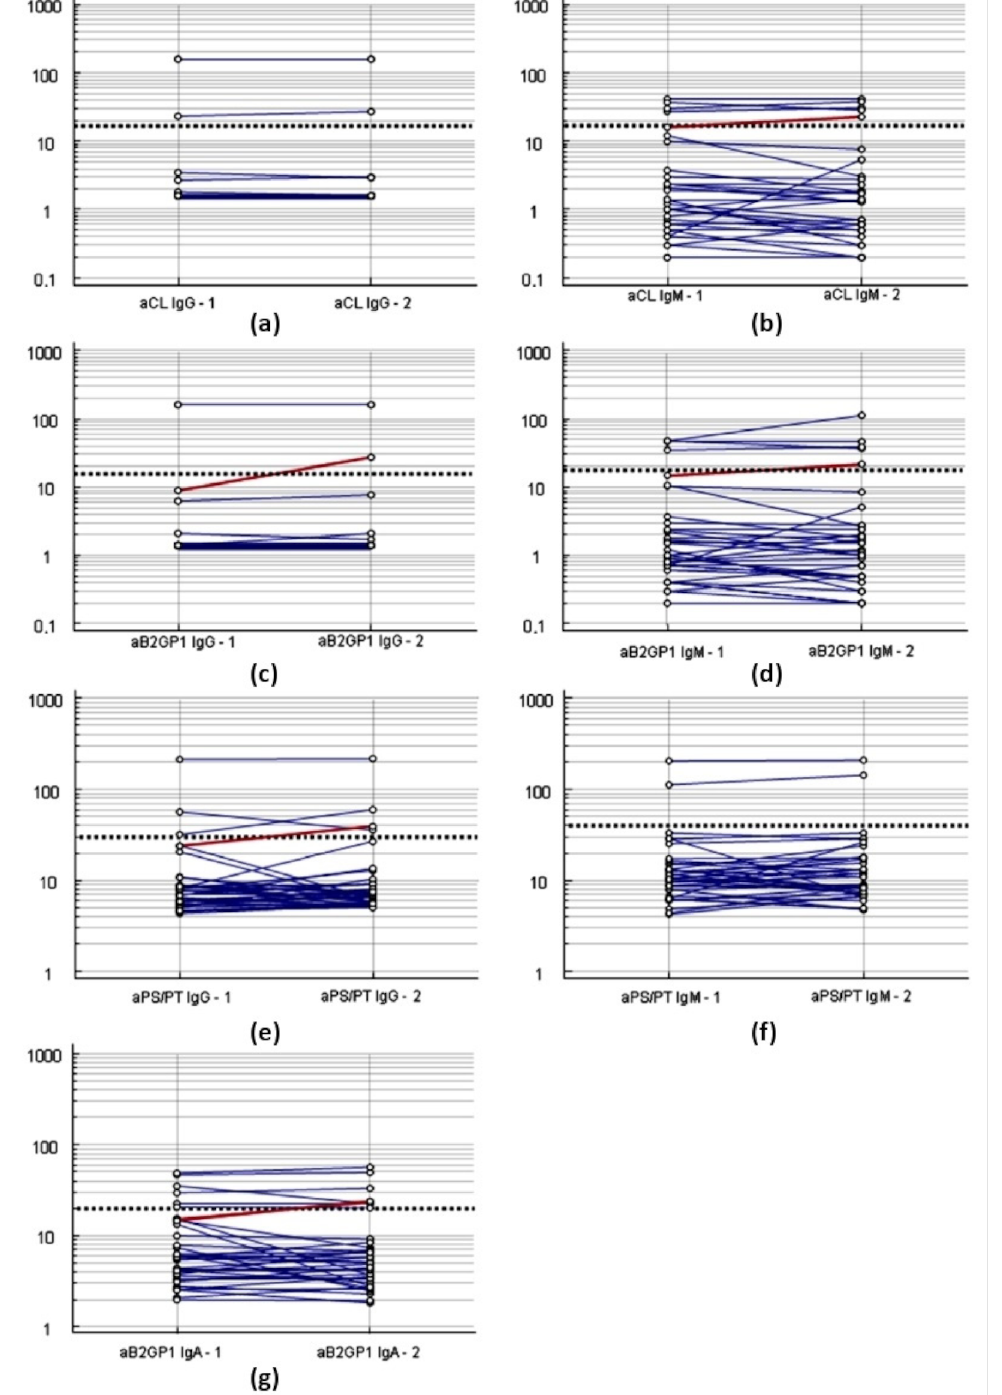
Figure 3. Dot and line diagram representing the Wilcoxon test of the paired samples of antiphos- pholipid antibodies in COVID-19 patients with thrombotic events. ( a ). Anti-cardiolipin (aCL) IgG. ( b ). aCL IgM. ( c ). Anti-B2GPI (aB2GPI) IgG. ( d ). aB2GPI IgM. ( e ). Anti-Phosphatidyl ser- ine/Prothrombin (aPS/PT) IgG. ( f ). aPS/PT IgM. ( g ). aB2GPI IgA. Left, sample1, Right, sample 2. The ordinate axis represents the level of antibodies in U / ml. Red line represent negative sera in the first sample that become positive in second sample. Dotted line represents the